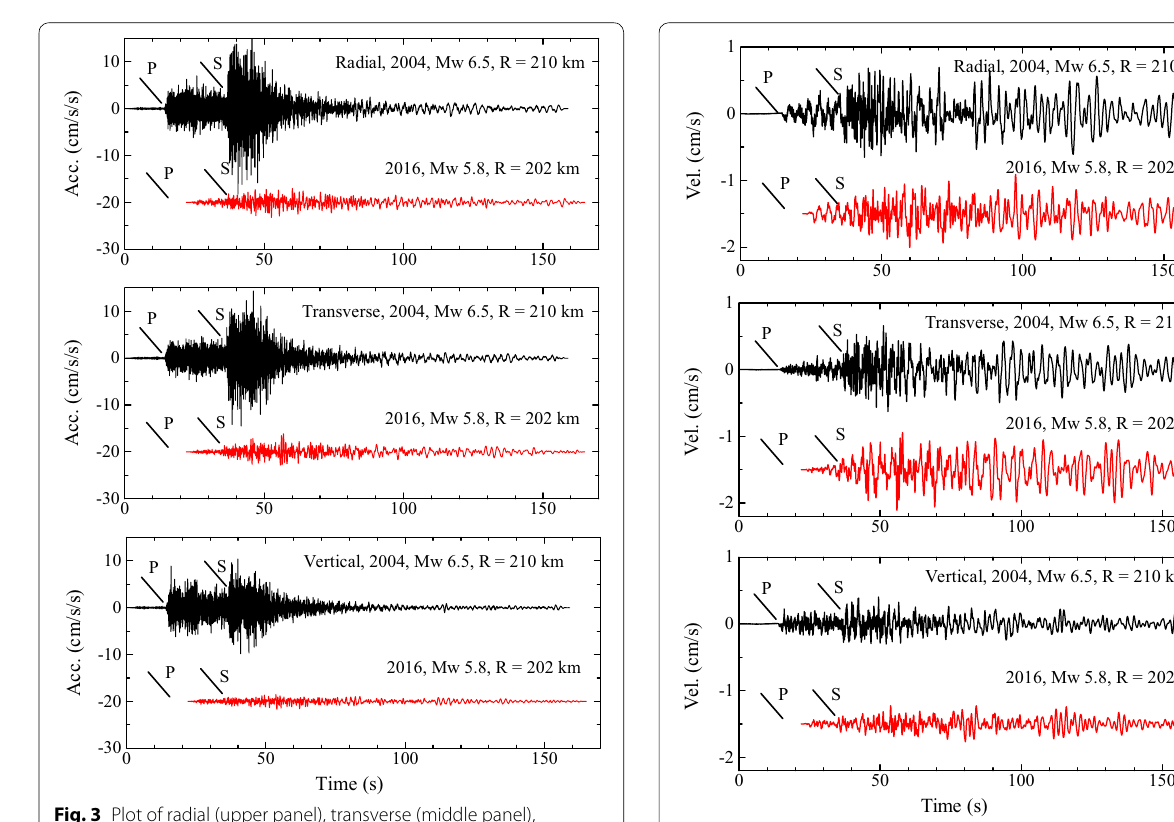
Fig. 4 Plot of radial (upper panel), transverse (middle panel), and vertical (lower panel) component velocity time histories at site AIC004 (see Fig. 1 for location) for the 2004 (upper trace in each panel) and 2016 (lower trace in each panel) events. The recordings are aligned to match the S-wave arrivals. The arrivals of P- and S-waves are indicated by the letters P and S, respectively. See Fig. 3 for the accelerograms at the site and Fig. 9 for a comparison of the adjusted PGAs and PGVs among the sites